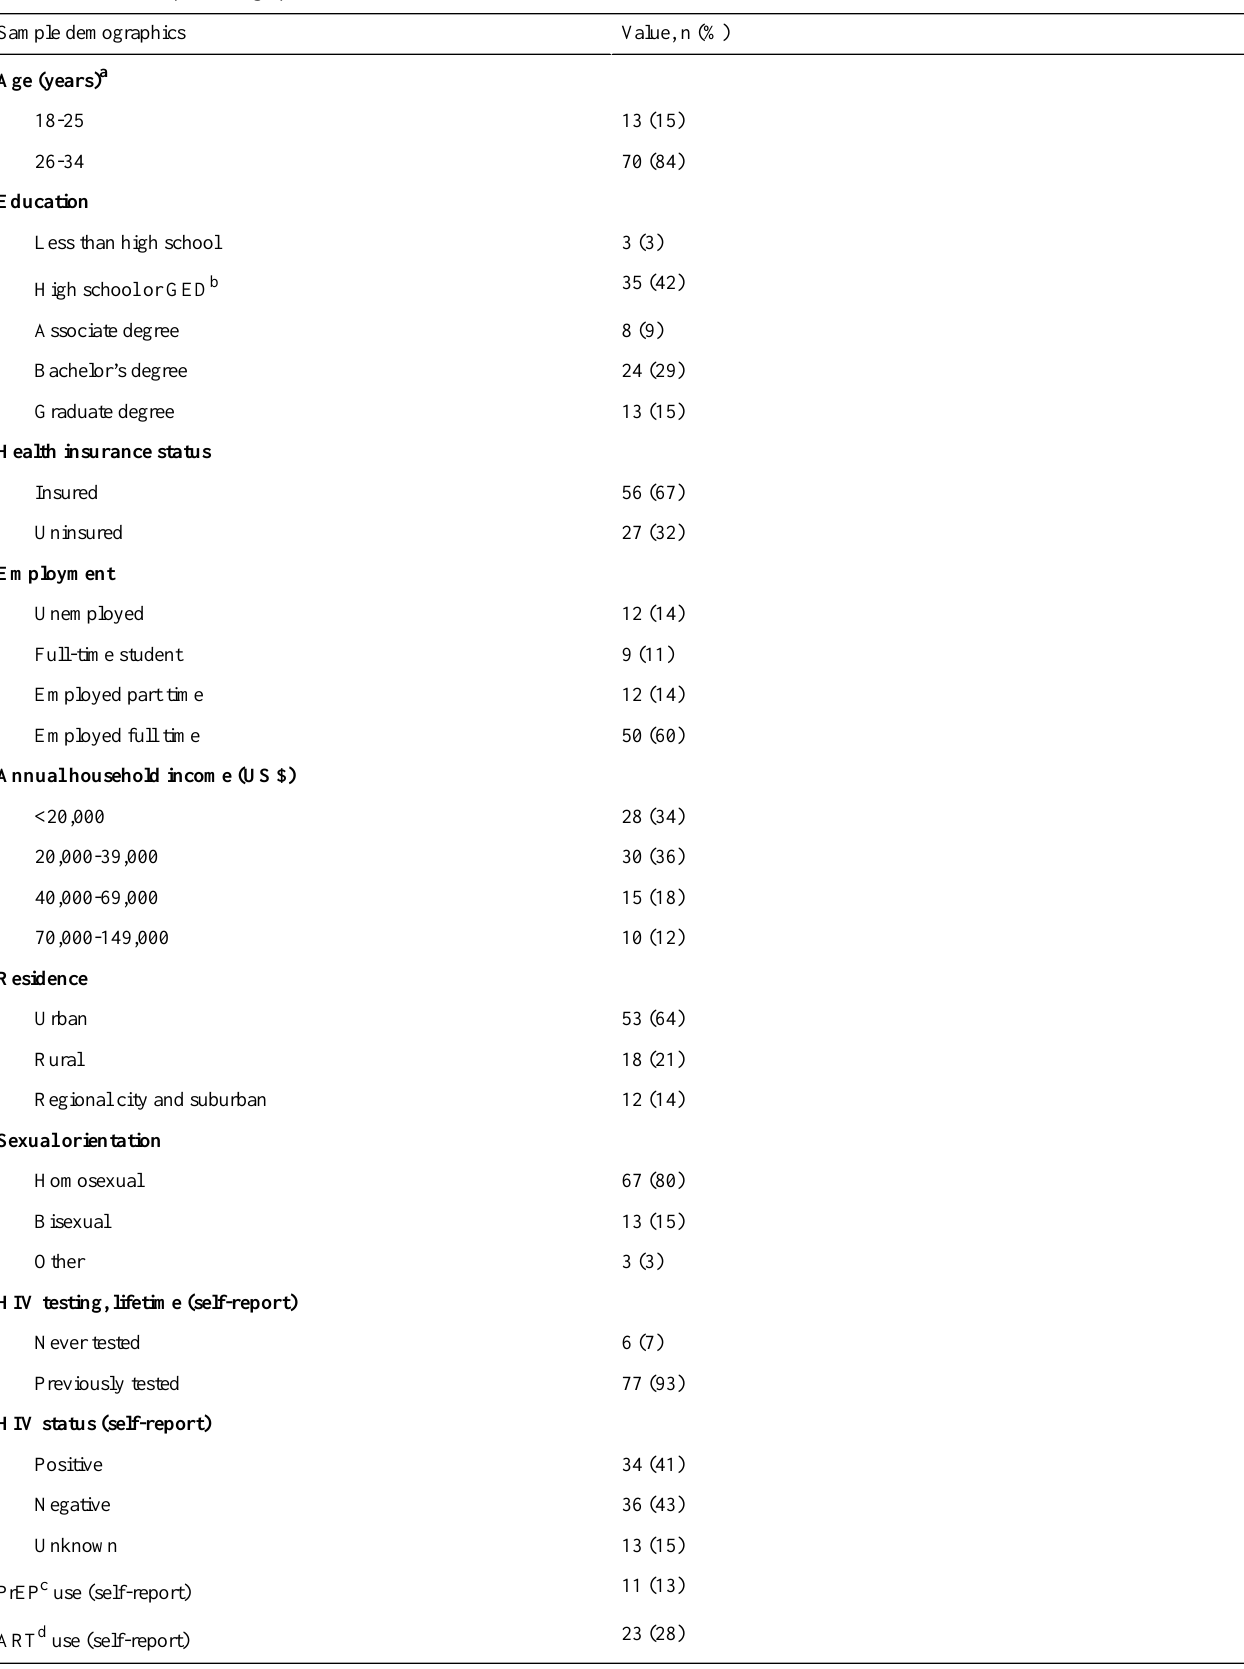
Table 1. Internet sample demographics